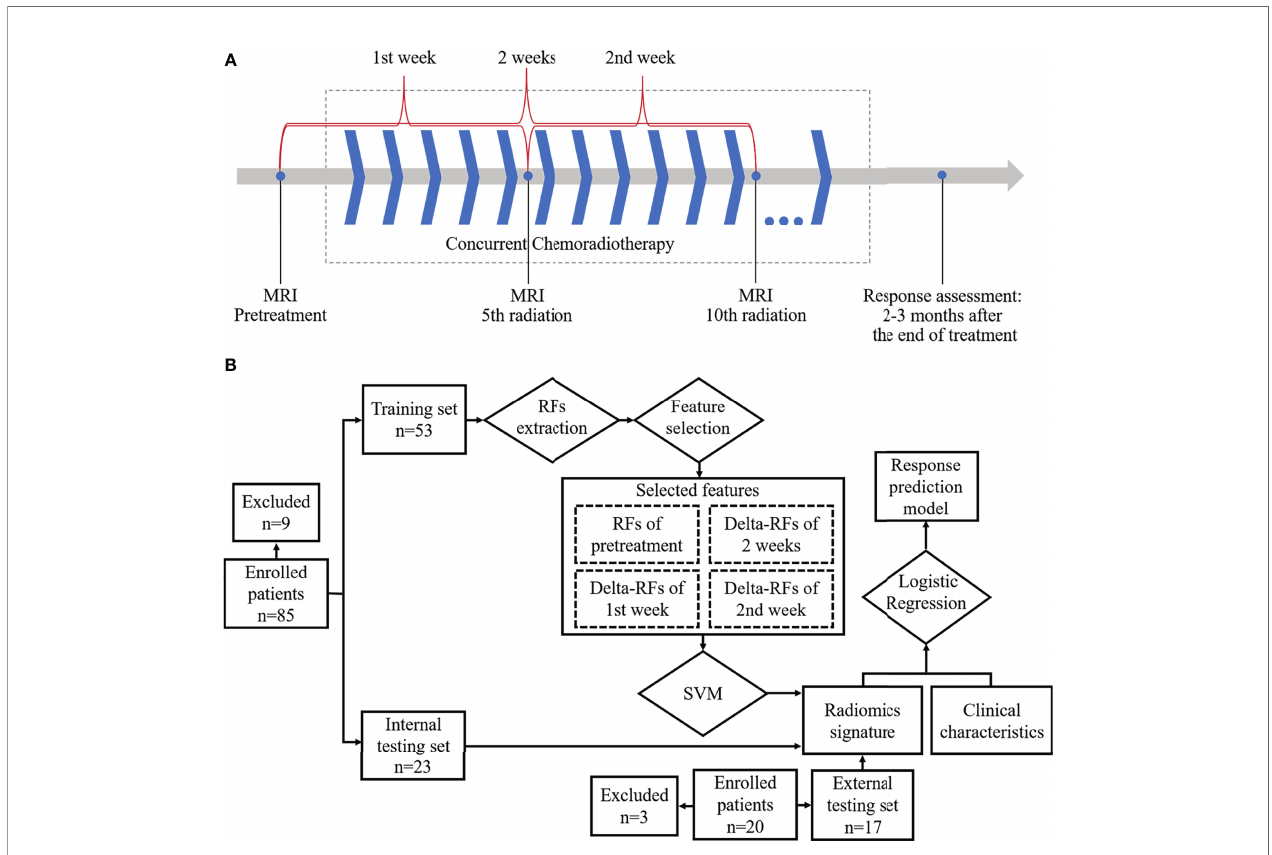
FIGURE 1 | Work fl ow: (A) Magneticresonance imaging acquisition schema and time ranges of thechange of radiomics features. (B) Work fl ow for buildingradiomics signature-based prediction